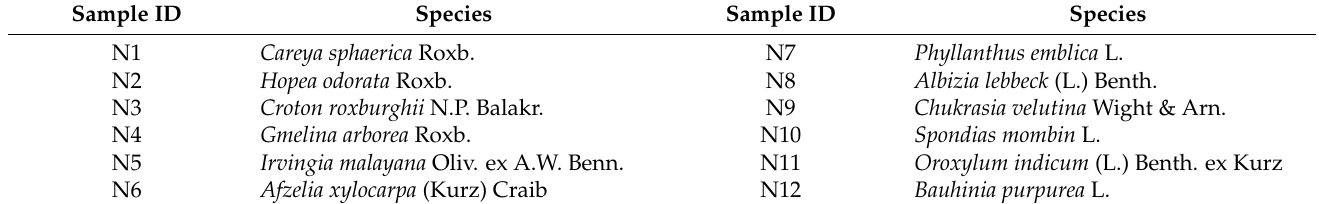
Table 1. Twelve native plants samples used in this study.